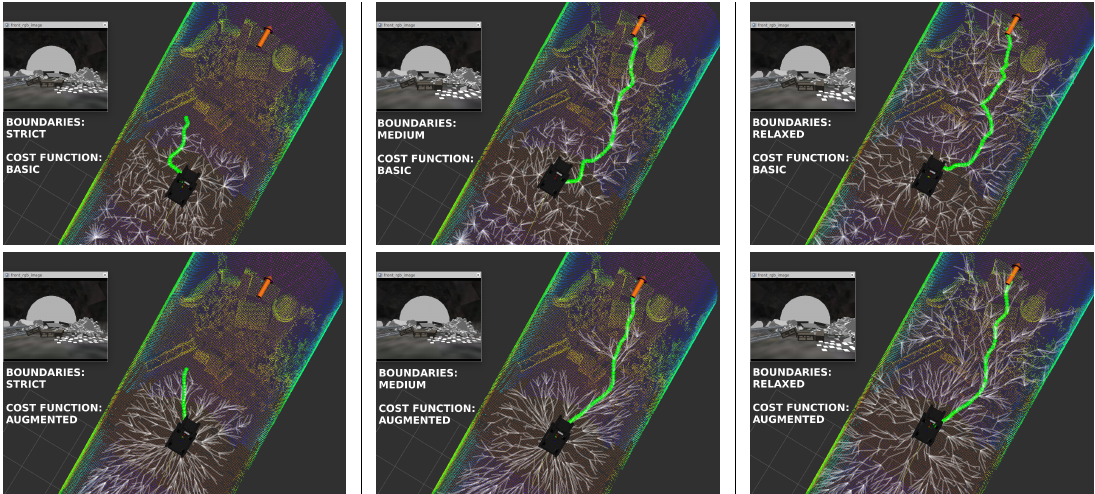
Figure 8. Visual comparison of different tree-expansion boundaries and cost functions.